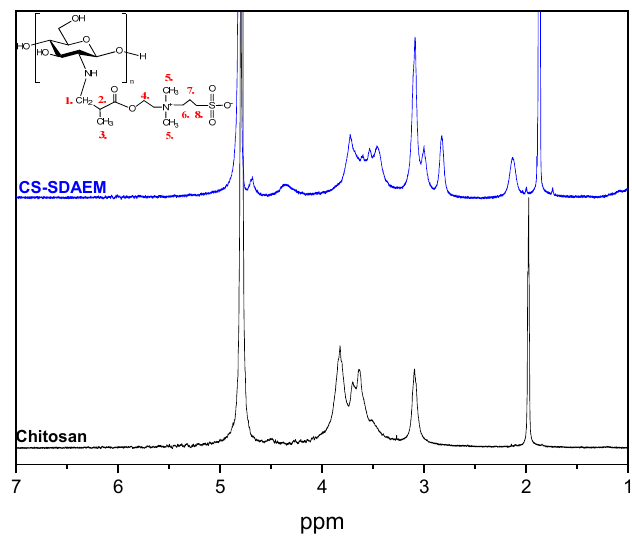
Figure 3. 1 H-NMR spectra of CS and CS-SDAEM derivative.